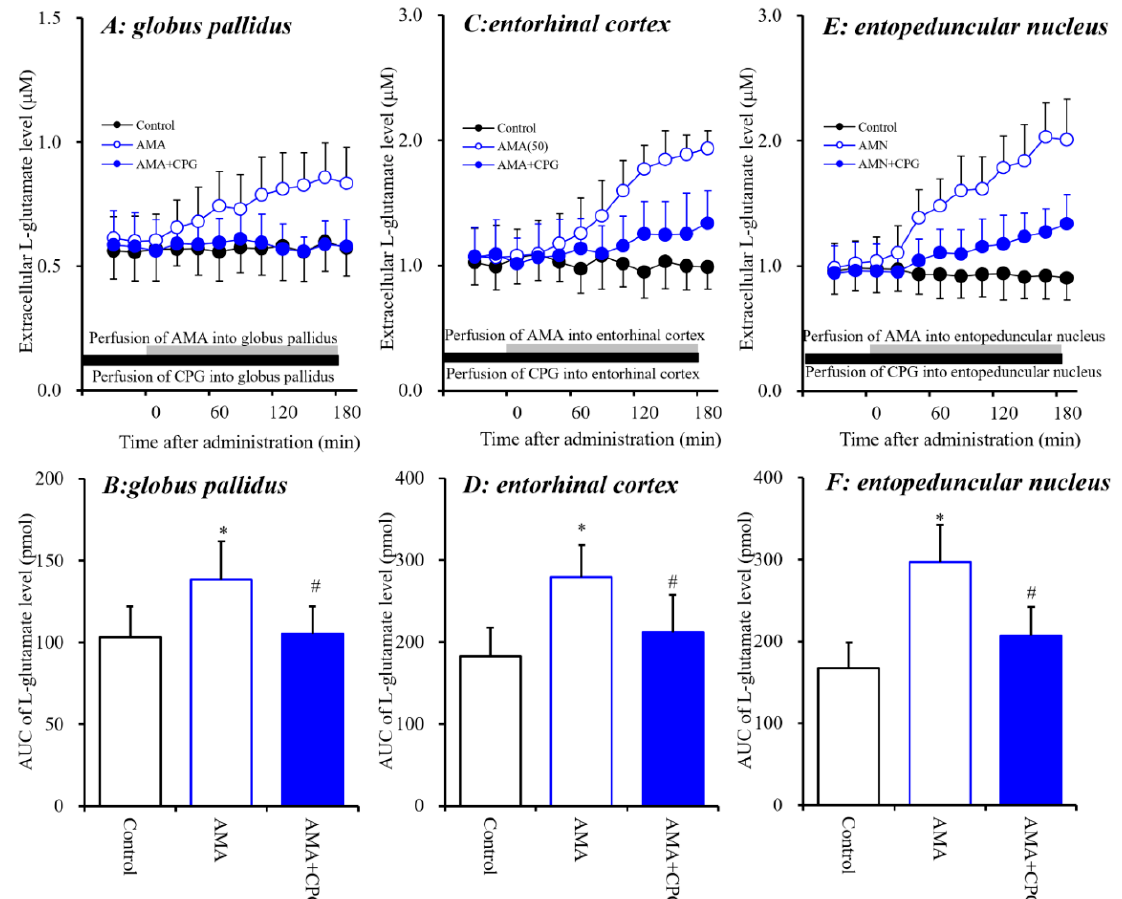
Figure 3. Interaction between perfusion with AMA (50 μ M) and CPG (1 μ M) into the globus pallidus, entorhinal cortex and entopeduncular nucleus and respective extracellular L-glutamate levels in the globus pallidus ( A , B ), entorhinal cortex ( C , D ) and entopeduncular nucleus ( E , F ). ( A , C , E ) indicate the effects of perfusion of AMA with or without CPG into the globus pallidus, entorhinal cortex and entopeduncular nucleus on extracellular L-glutamate levels, respectively. The initial perfusion medium was MRS with or without CPG (1 μ M) (black bars). After the stabilization of L-glutamate levels in the perfusate, the perfusion medium was switched to the same MRS containing AMA (50 μ M) (gray bars). Ordinates: mean ± SD ( n = 6) of the extracellular L-glutamate level ( μ M); abscissa: time after administration of AMA (min). ( B , D , F ) indicate the AUC values of extracellular L-glutamate levels (pmol) after 20 to 180 min perfusion with the target agent in ( A , C , E ). * p < 0.05 relative to the control, and # p < 0.05 relative to AMA by LME with Tukey’s post hoc test.